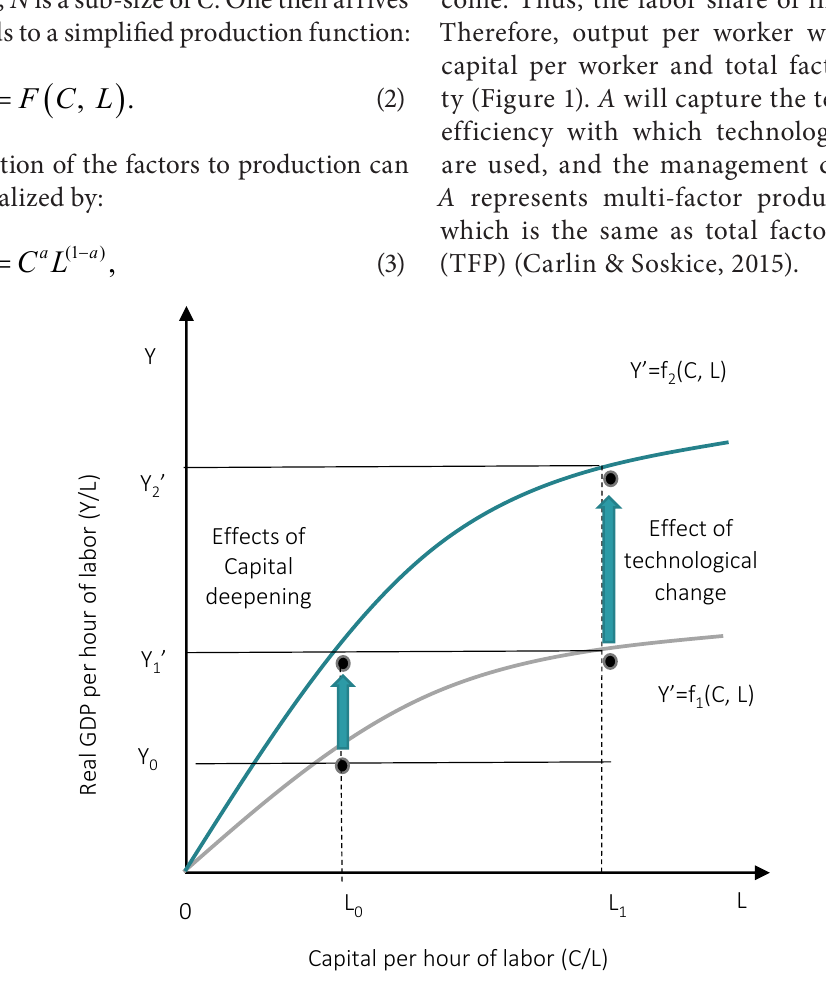
Figure 1. Effects of technological change on the neoclassical production